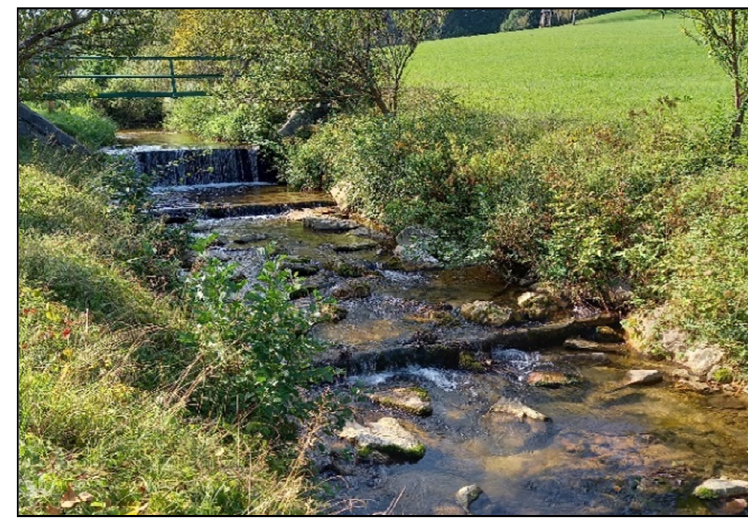
Figure 1. Weir at the Radušnica stream in Slovenia (photo by G. Novak).